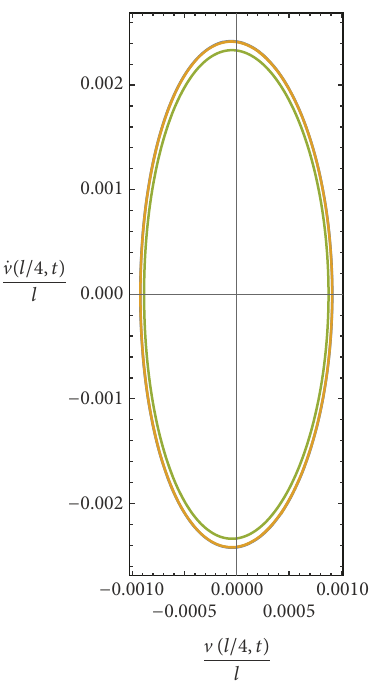
Figure 9: Case-study 2: reconstituted phase plot ( V , ̇ V ) for 𝑈 2 /𝑈 𝑐 = 0.09 at quarter-span (green line: multiple scale method; blue line: Galerkin method; orange line: finite difference